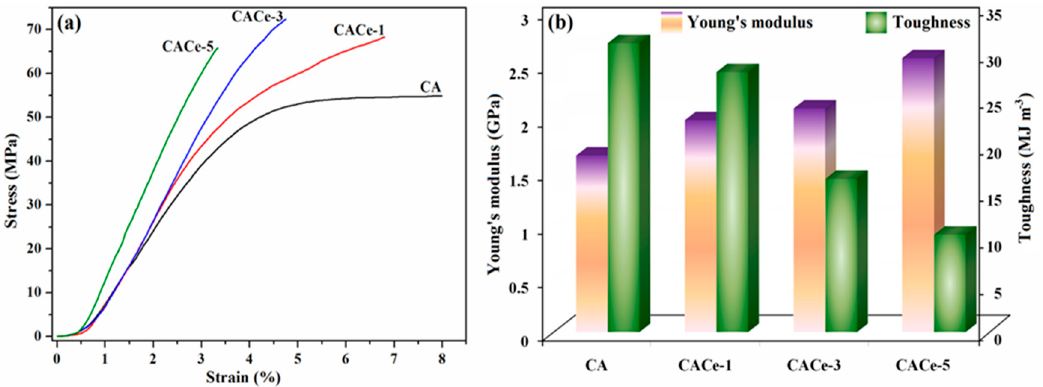
Figure 7. Stress–strain curves recorded for CA samples with and without CeO 2 NPs ( a ) and the variation of Young’s modulus and toughness in the investigated composite series ( b ). Table 1. Mechanical parameters for the investigated